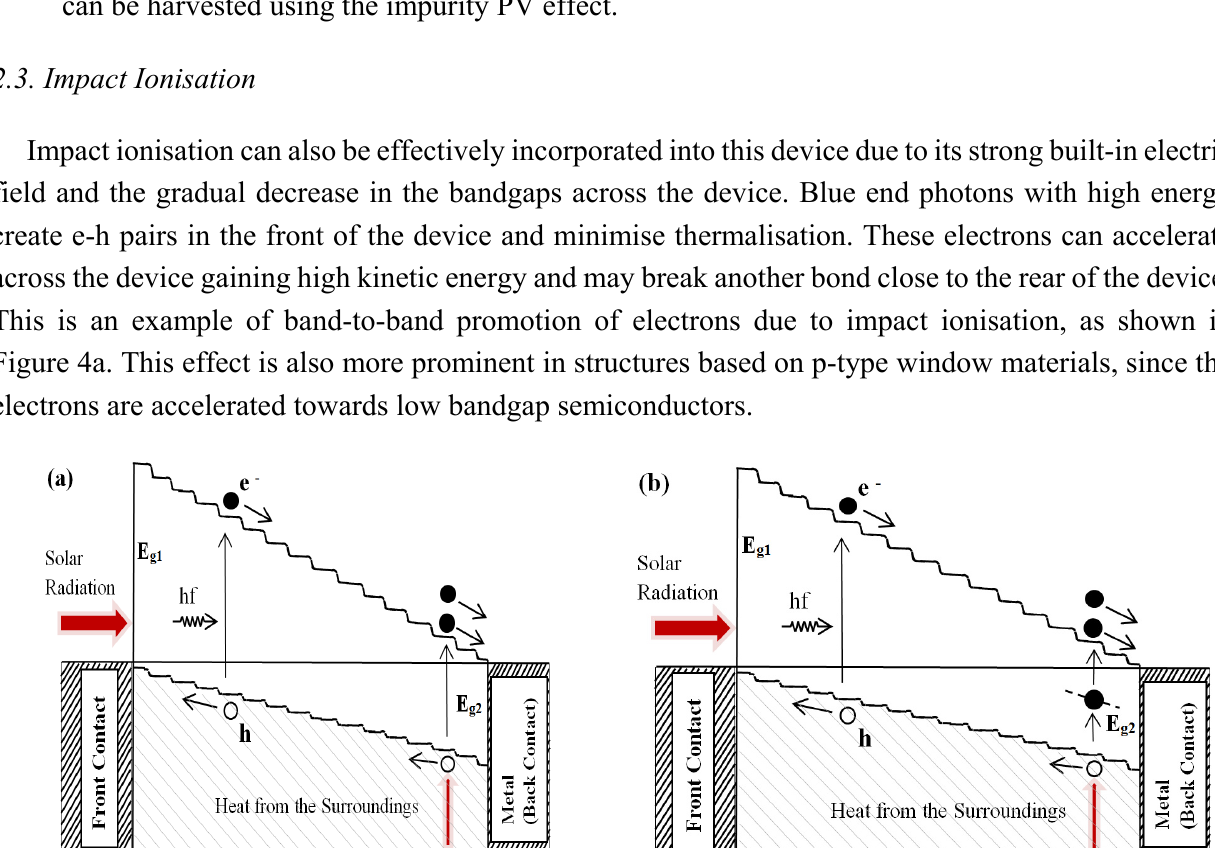
Figure 3. Effective use of naturally occurring defects in semiconductors to create e-h pairs by multi-step photon absorption. Photons with energy less than the smallest bandgap (E g2 ) can be harvested using the impurity PV effect.